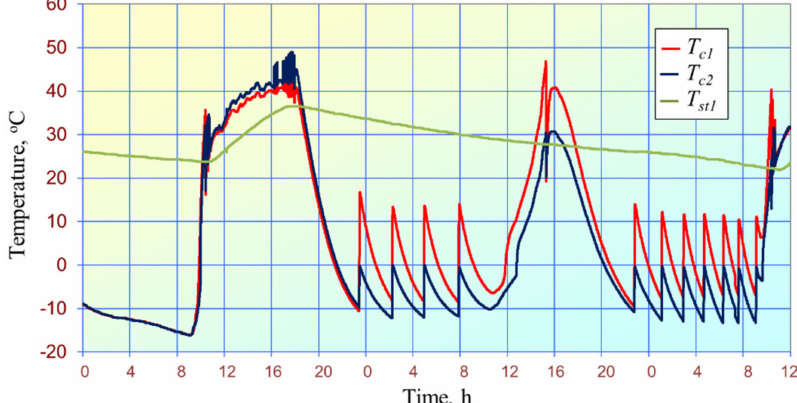
Figure 14. Night temperatures of collectors with circulating pump control for an average temperature of collectors, measurements were taken between 18 and 20 February 2021.